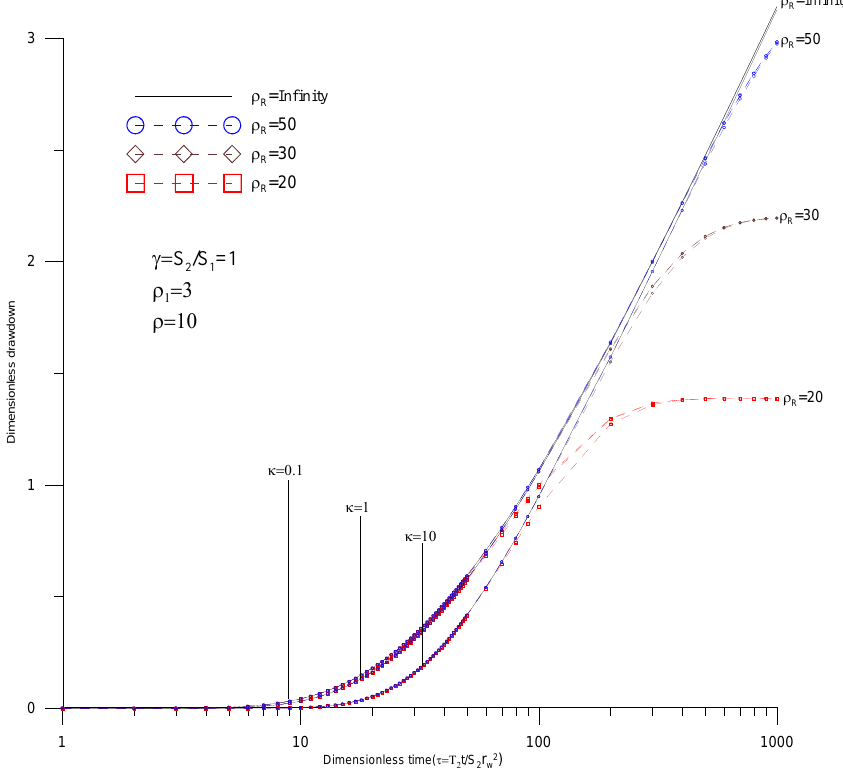
Fig. 3. The predicted drawdown curves at ρ = 10 ( in formation zone) for infinite aquifers denoted by the solid line and for finite aquifers having the outer boundary distances of 20, 30, and 50 represented by the dashed lines with the symbols of circle, diamond, and square, respectively, for ρ 1 =3, γ =1 and κ =0.1, 1 and 10.